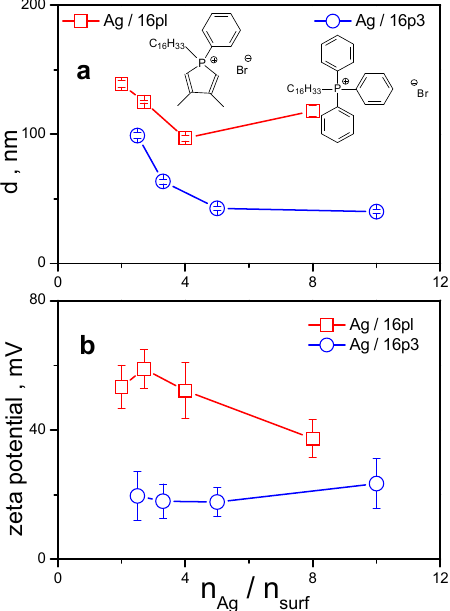
Figure 7. ( a ): Hydrodynamic size d of silver nanoparticles stabilized with hexadecyldimethylphenylphospholium surfactant 16pl , and with hexadecyltriphenylphosphonium surfactant 16p3 plotted against n Ag /n surf . ( b ): Zeta potential of AgNPs plotted against n Ag /n surf .